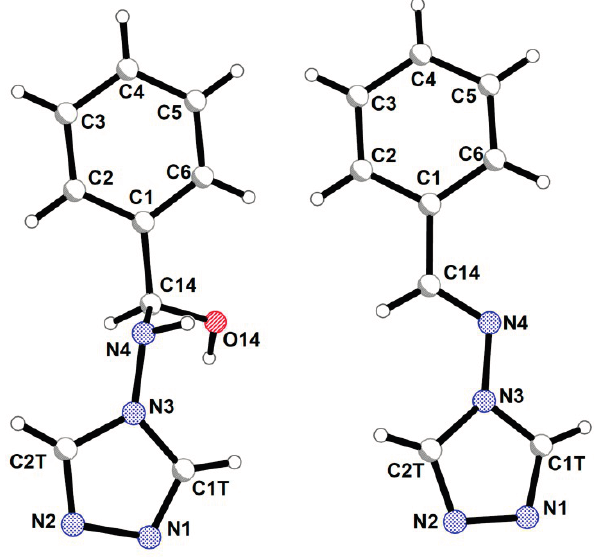
Figure 2. General atom numbering pattern in the crystals of hemiaminals and imines.